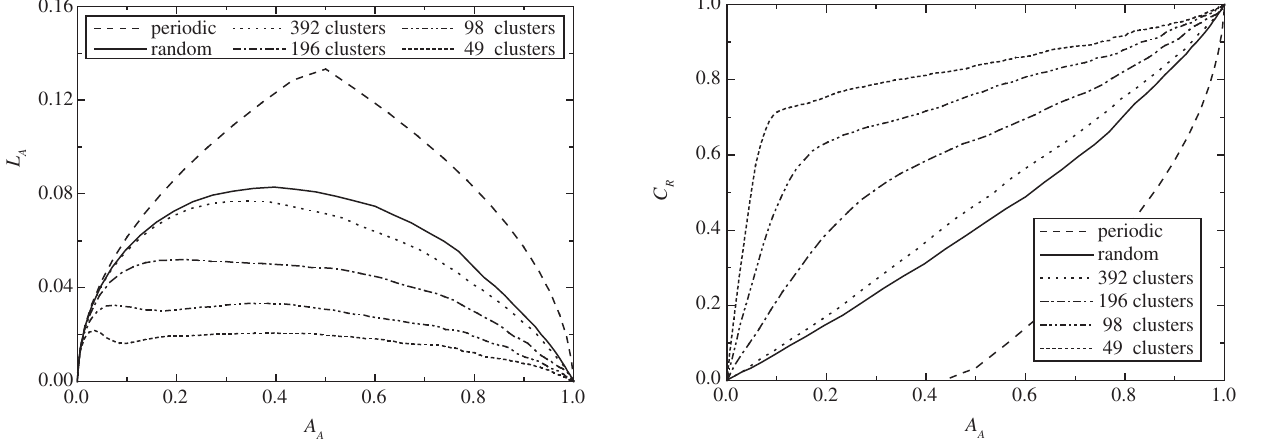
Figure 4. Interfacial area length between recrystallized grains and matrix, L , against area fraction, simulated by CA. The maximum in L A pronounced for a periodic nuclei arrangement and less pronounced for clusters.